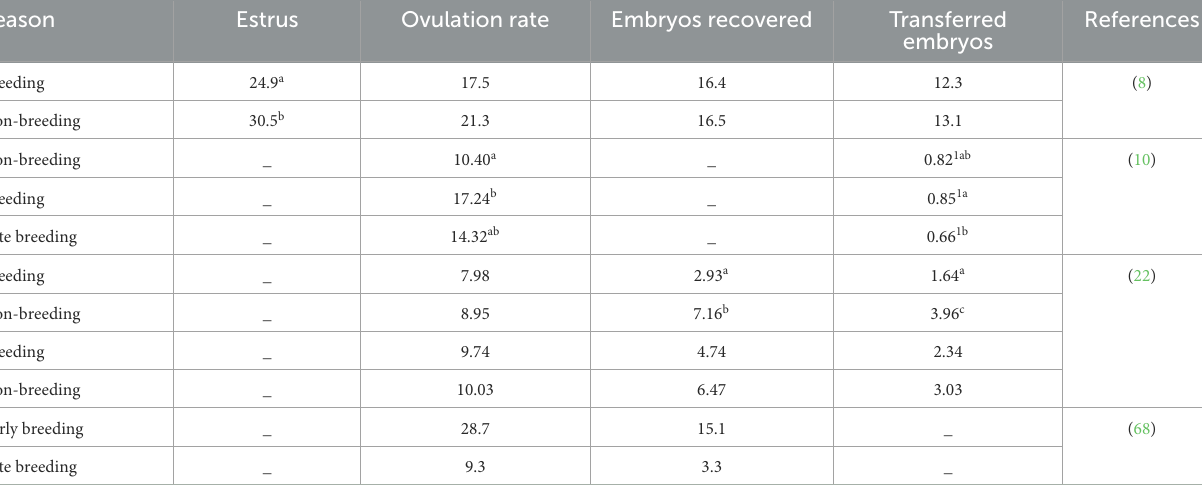
TABLE 3 Different seasons influence the ovarian